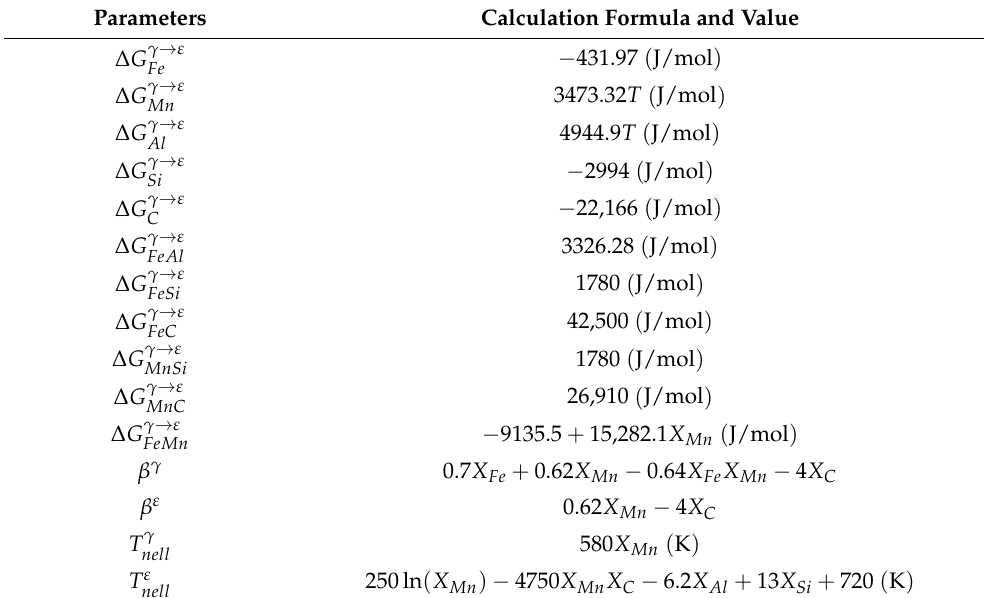
Table 3. Calculation formulae involved in the stacking fault energy model [18–20]. ∆ G γ → ε the Gibbs free energy difference between γ fcc → ε hcp phase of component i . β is the magnetic parameter related to the composition. T nell : the Nell temperature.